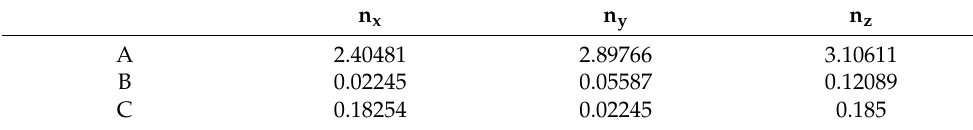
Table 22. Sellmeier parameters for the refractive index dispersion of Equation (27) [97].